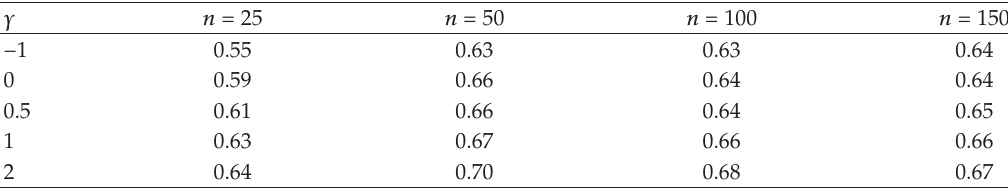
Table 10: Empirical coverage probabilities for the exponential distribution under right censoring.